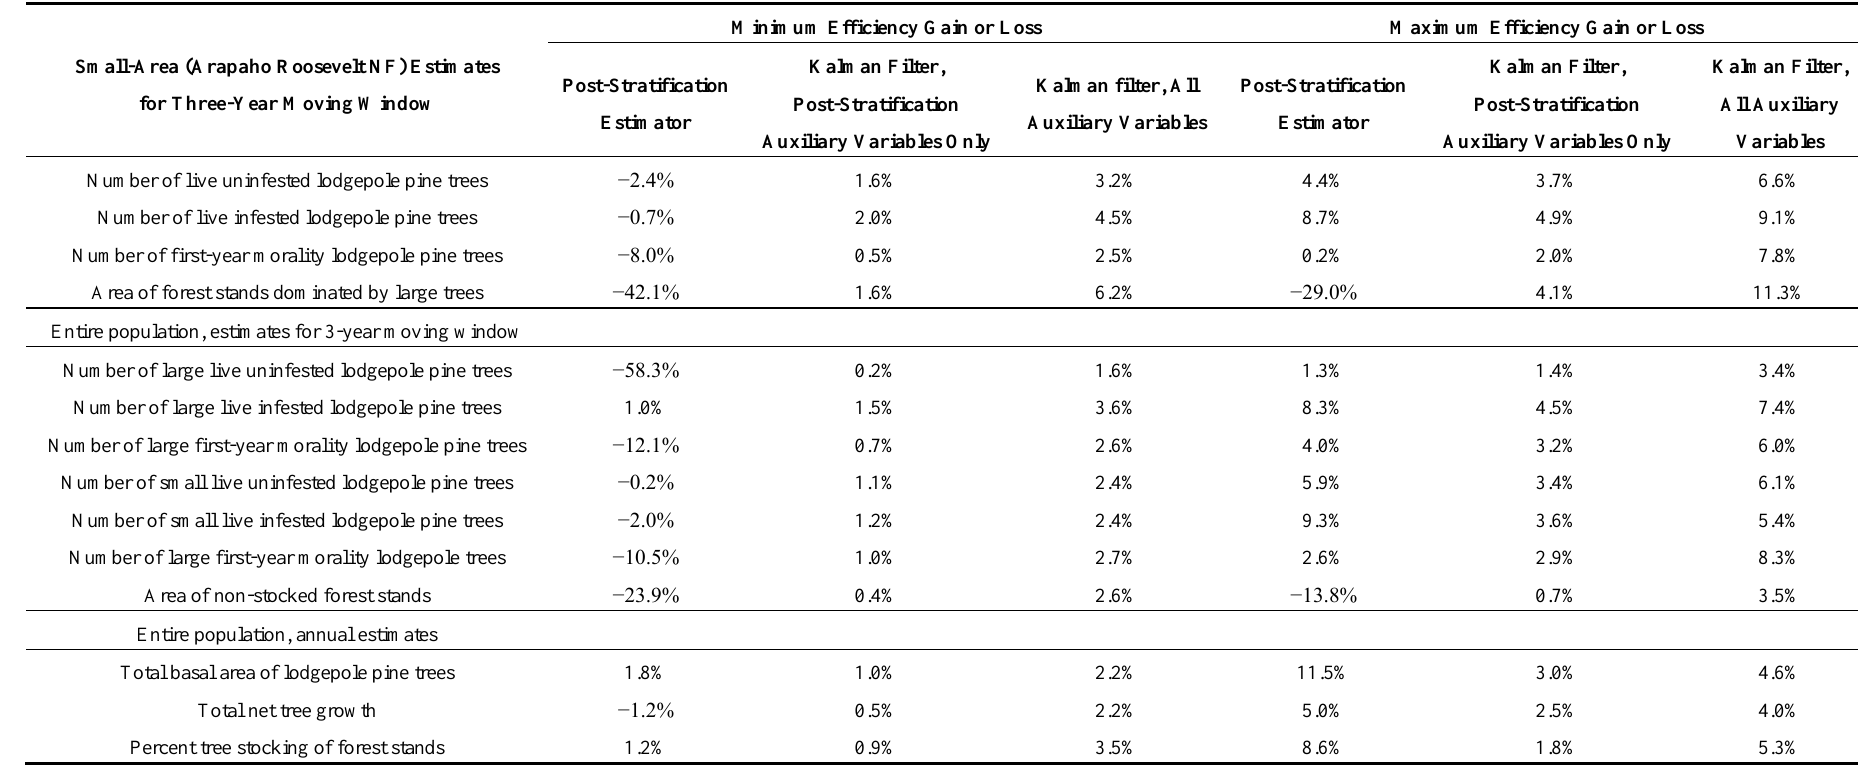
Table 1. Change in statistical efficiency with auxiliary sensor data. The minimum and maximum statistics among 11 years are presented. Negative values indicate a loss of statistical